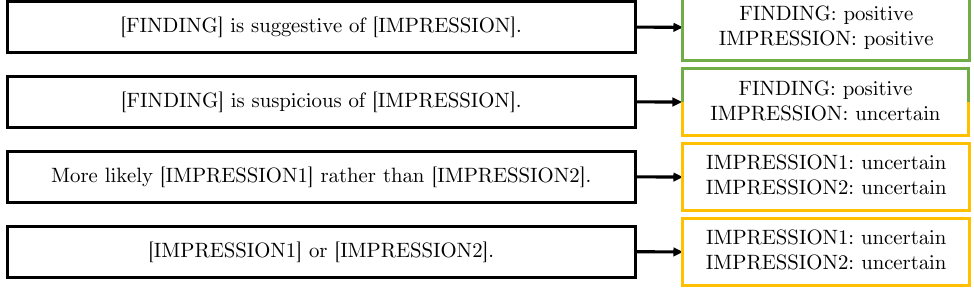
Figure 7. Protocol-derived templates which generate examples of protocol-specific rules in